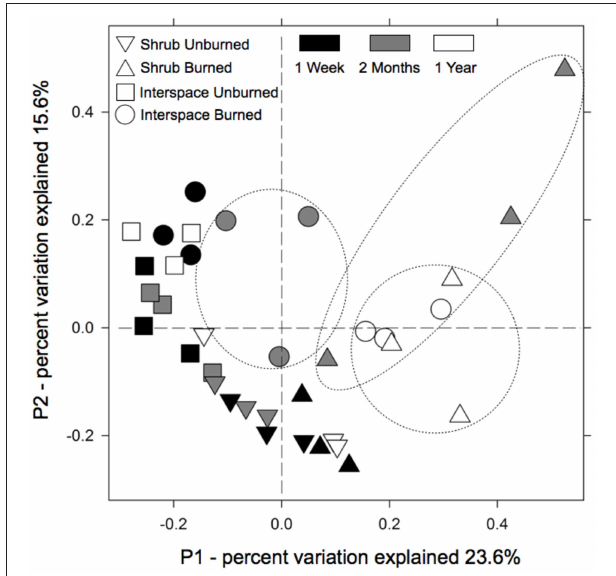
FIGURE 1 | Bacterial communities in burned Cyanobacteria/lichen-dominated (interspaces) and Cyanobacteria/moss-dominated (shrubs) biocrusts converged to a common composition 1 year after the fire. The multivariate ordination was generated using principle coordinate analysis (PCoA) on a sample × OTU matrix of 16S rRNA gene community libraries (97% similarity